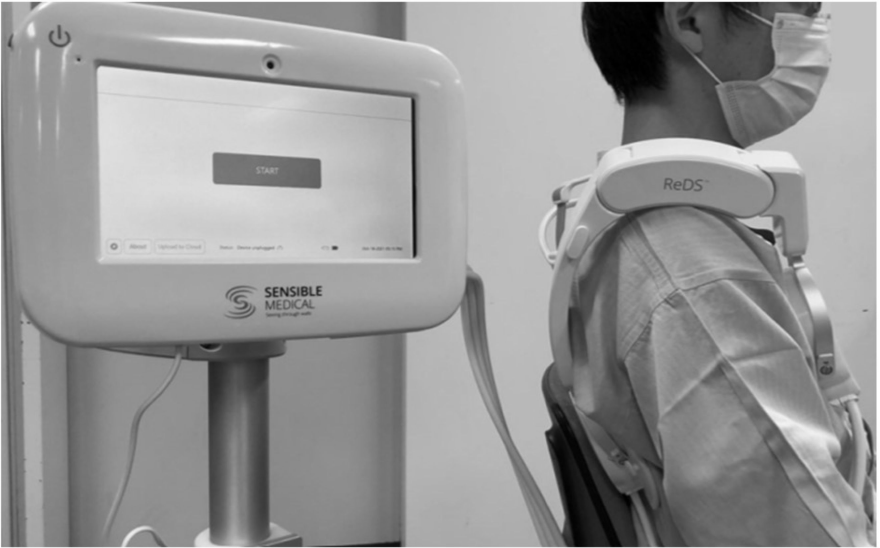
Figure 1. A ReDS system consisting of a monitor and a sensor